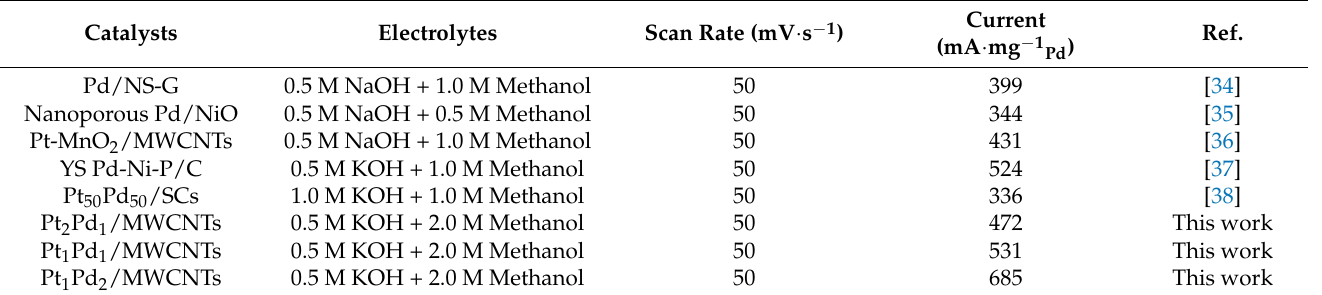
The synergistic effect of the PtPd alloy can not only promote the oxidation of